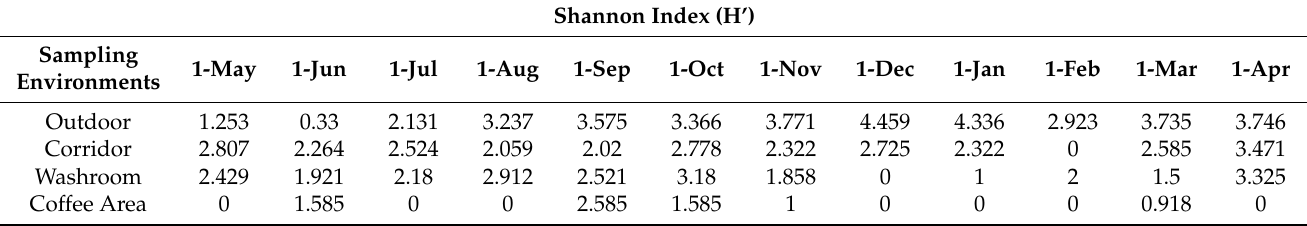
Table 2. Shannon index of diversity of fungal communities in different sampling environments throughout the